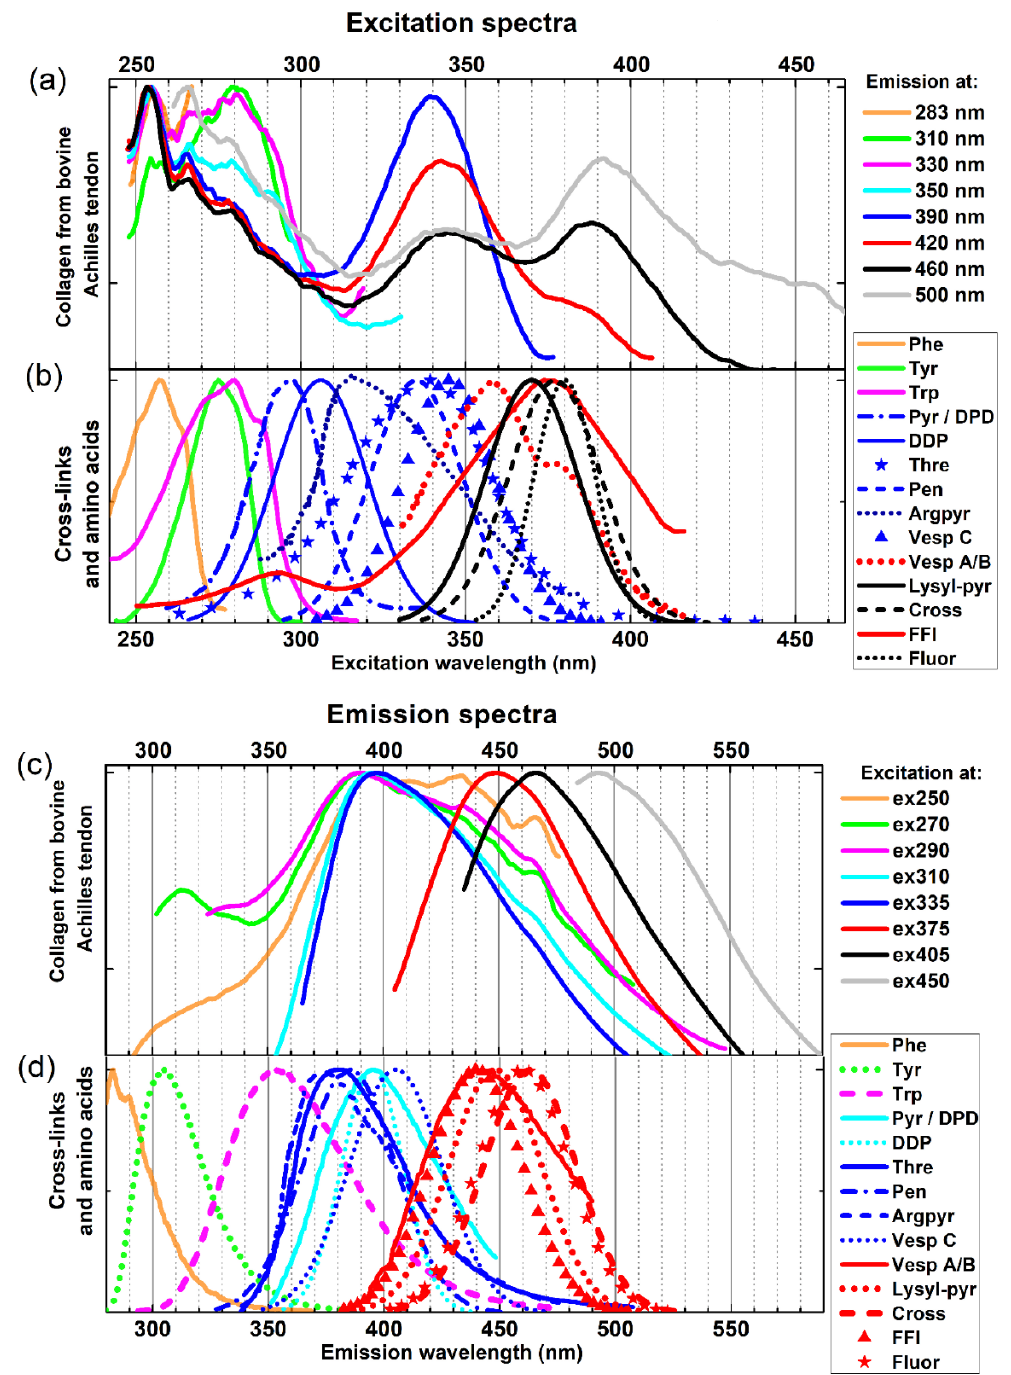
Figure 1. Fluorescence excitation (panel ( a )) and emission (panel ( c )) spectra of insoluble collagen powder from bovine Achilles tendon. Panels ( b , d ) display the excitation and emission fluorescence spectra of amino acids measured in water and similar simulated spectra of known fluorescent cross-links of collagen protein (see text for